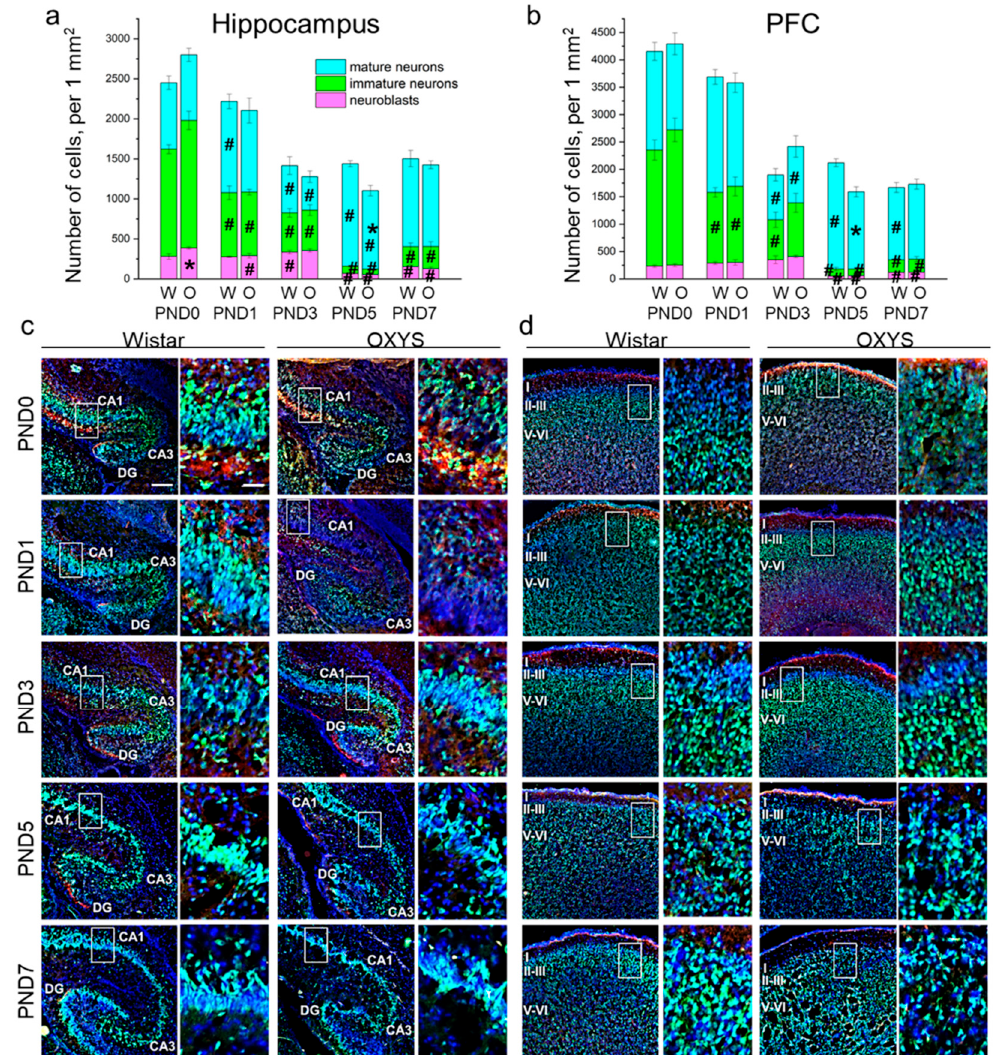
Figure 2. The density of neuroblasts and immature and mature neurons in the hippocampus ( a ) and PFC ( b ) of OXYS and Wistar rats during the first postnatal week. Microphotographs of the hippocampus ( c ) and PFC ( d ) stained by antibodies against NeuN (green) and DCX (red); DAPI indicates cell nuclei. Scale bars are 200 µ m and 50 µ m (within the frame). W: Wistar; O: OXYS; I: cortical layer I; II-III: cortical layers II–III; V-VI: cortical layers V–VI. The data ( a , b ) are presented as mean ± SEM; * p < 0.05 for differences between the strains; # p < 0.05 for differences from a previous time point.